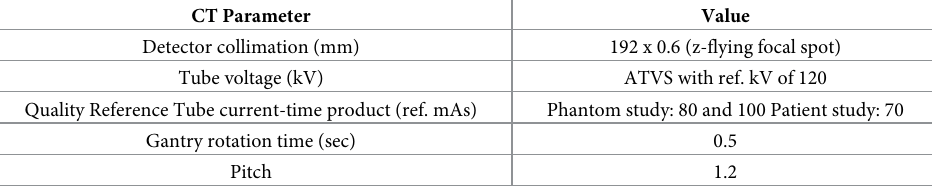
Table 1. CT scan parameters.